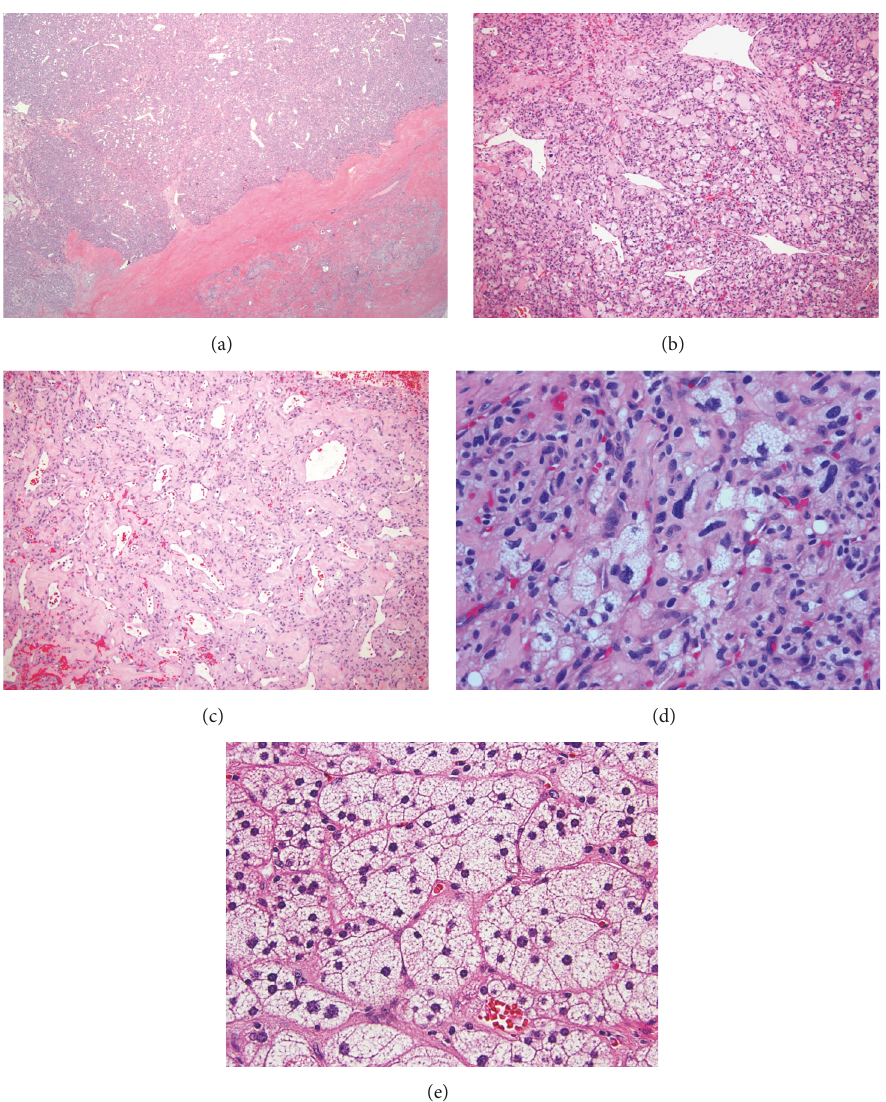
Figure 3: Histological examination demonstrated a well circumscribed and cellular lesion with a thin fibrous capsule ((a), H&E stain, 50x). The lesion was composed of sheets of cells with interspersed abundant capillaries and scattered large vessels ((b), H&E stain, 100x). At low power, patchy areas resembled a capillary hemangioma ((c), H&E stain, 100x). High power examination showed large neoplastic cells with foamy cytoplasm and irregular hyperchromatic nuclei, mimicking the native adrenal cortical cells, admixed with benign-appearing capillaries ((d), H&E, 400x). Native adrenal cells ((e), H&E,